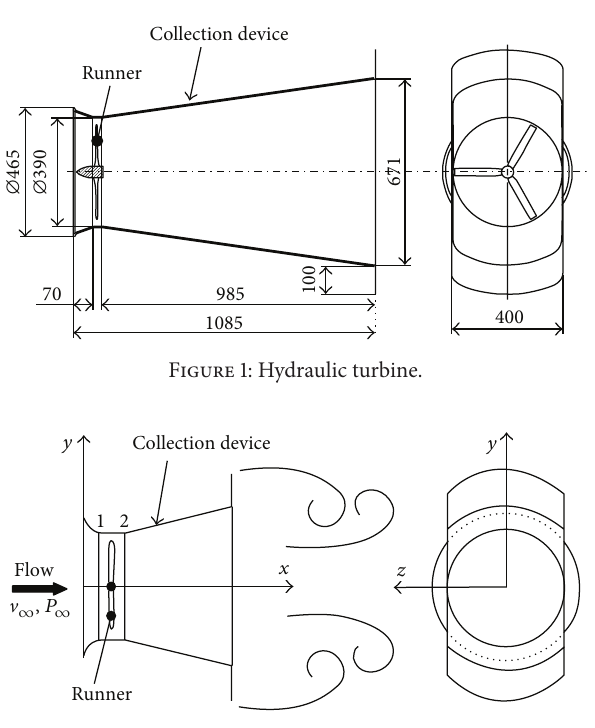
Figure 2: The definition of a coordinate